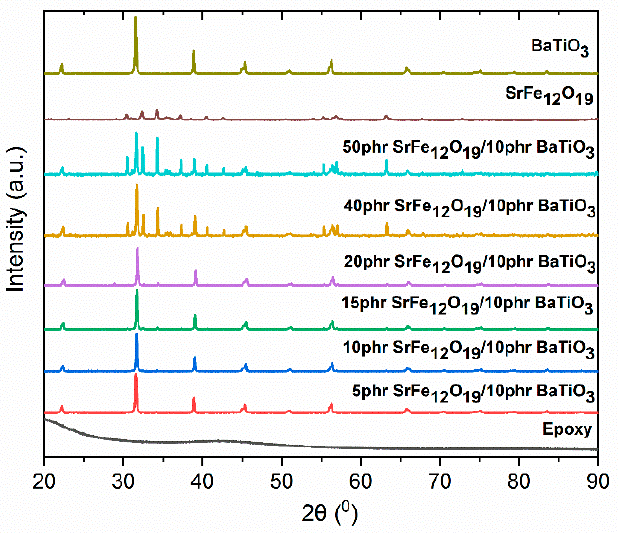
Figure 2. XRD patterns of all studied systems and SrFe 12 O 19 , BaTiO 3 powders.